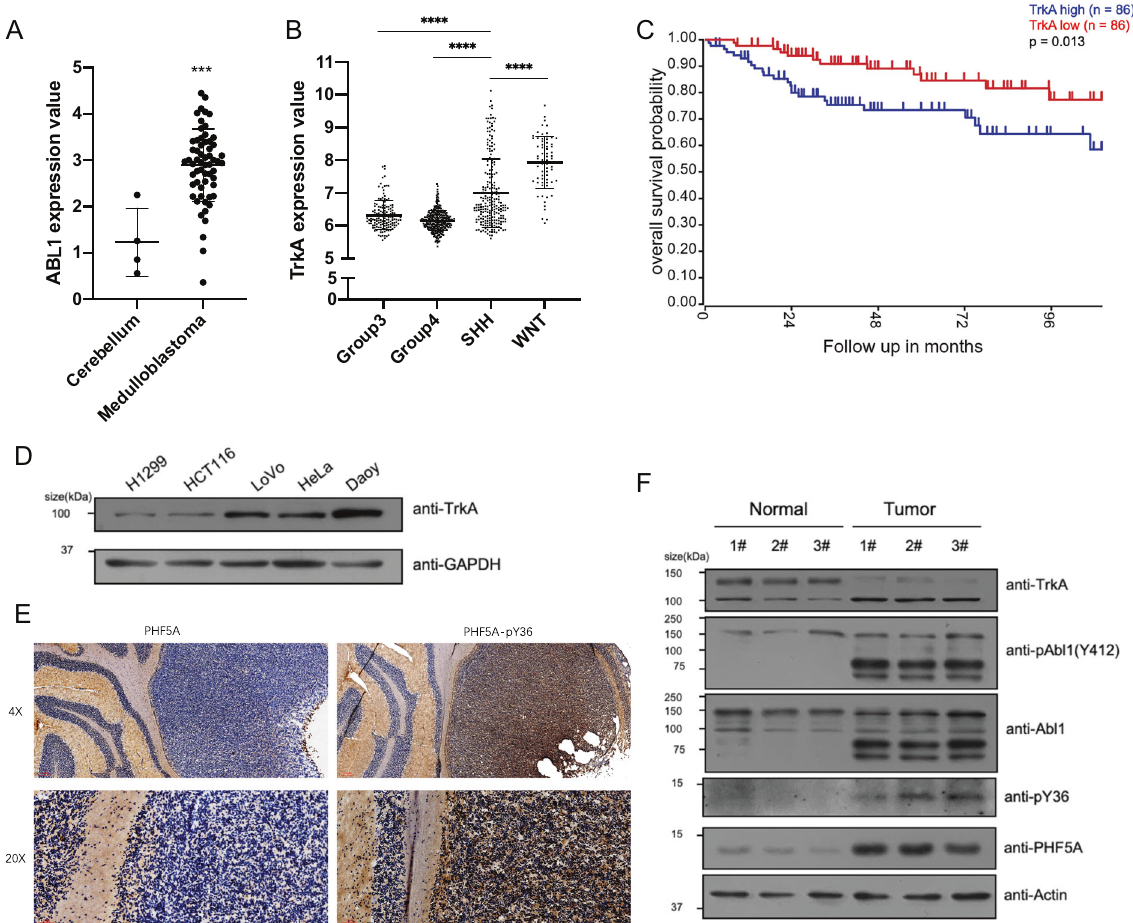
Fig. 6 pY36-PHF5A hyper-phosphorylates in medulloblastoma. A ABL1 expression level was analyzed with a microarray of samples from Oncomine: normal cerebellum ( n = 4) and medulloblastoma ( n = 67). B TrkA expression level was analyzed with microarray analysis of 763 primary medulloblastomas from GEO (GSE85217): Group 3 ( n = 144), Group 4 ( n = 326), SHH ( n = 223), and WNT ( n = 70). C Kaplan – Meier analysis was performed in two groups of Shh-subtype medulloblastomas from GEO (GSE85217) for TrkA expression. D Indicated cell lines were used to verify the expression level of TrkA. E Immunohistochemistry staining for PHF5A and pY36-PHF5A in Shh-subtype medulloblastoma mouse model. F Immunoblotting was performed in normal cerebellum or medulloblastoma of Shh-subtype mouse model with indicated